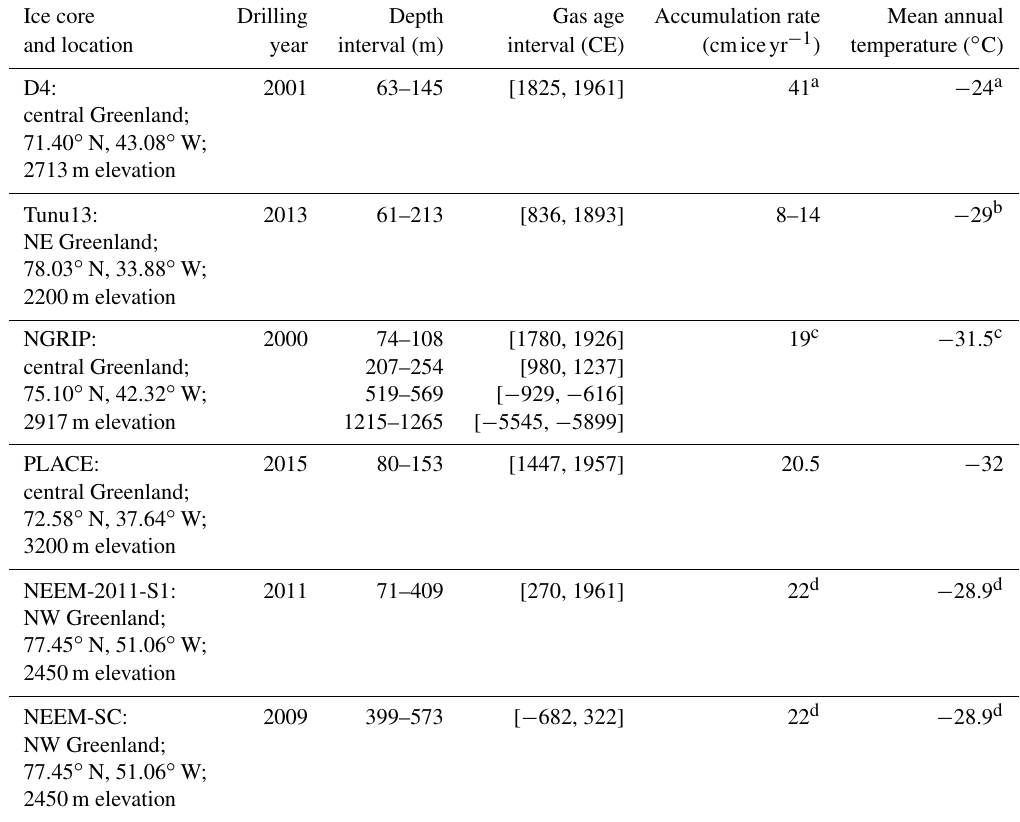
Table 1. Locations, site characteristics, and other relevant information for ice cores featured in this study. Ice